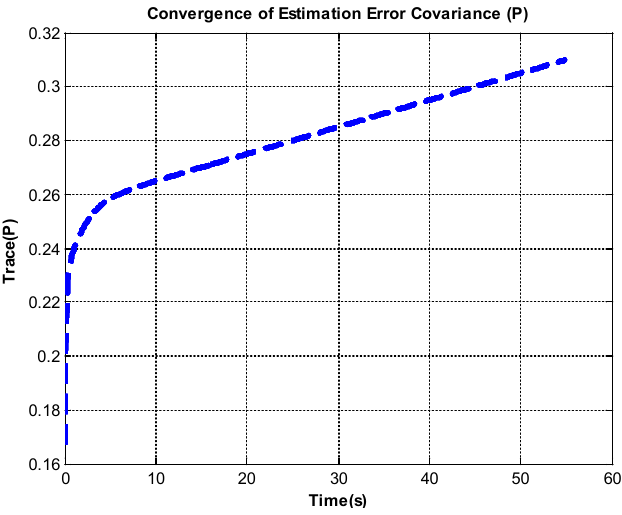
Figure 15. Convergence of the estimation error covariance.